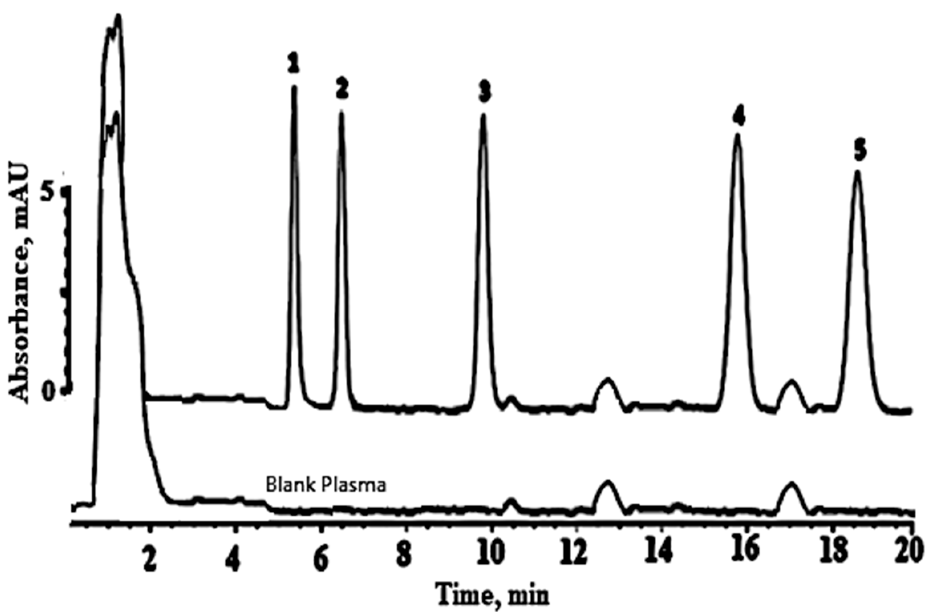
Figure 5. Chromatogram of a plasma matrix containing a mixture of 70 ng mL − 1 of bromazepam, clonazepam, lorazepam, nordiazepam, and diazepam compared with a blank plasma sample at the optimum conditions as described in Figure 4.